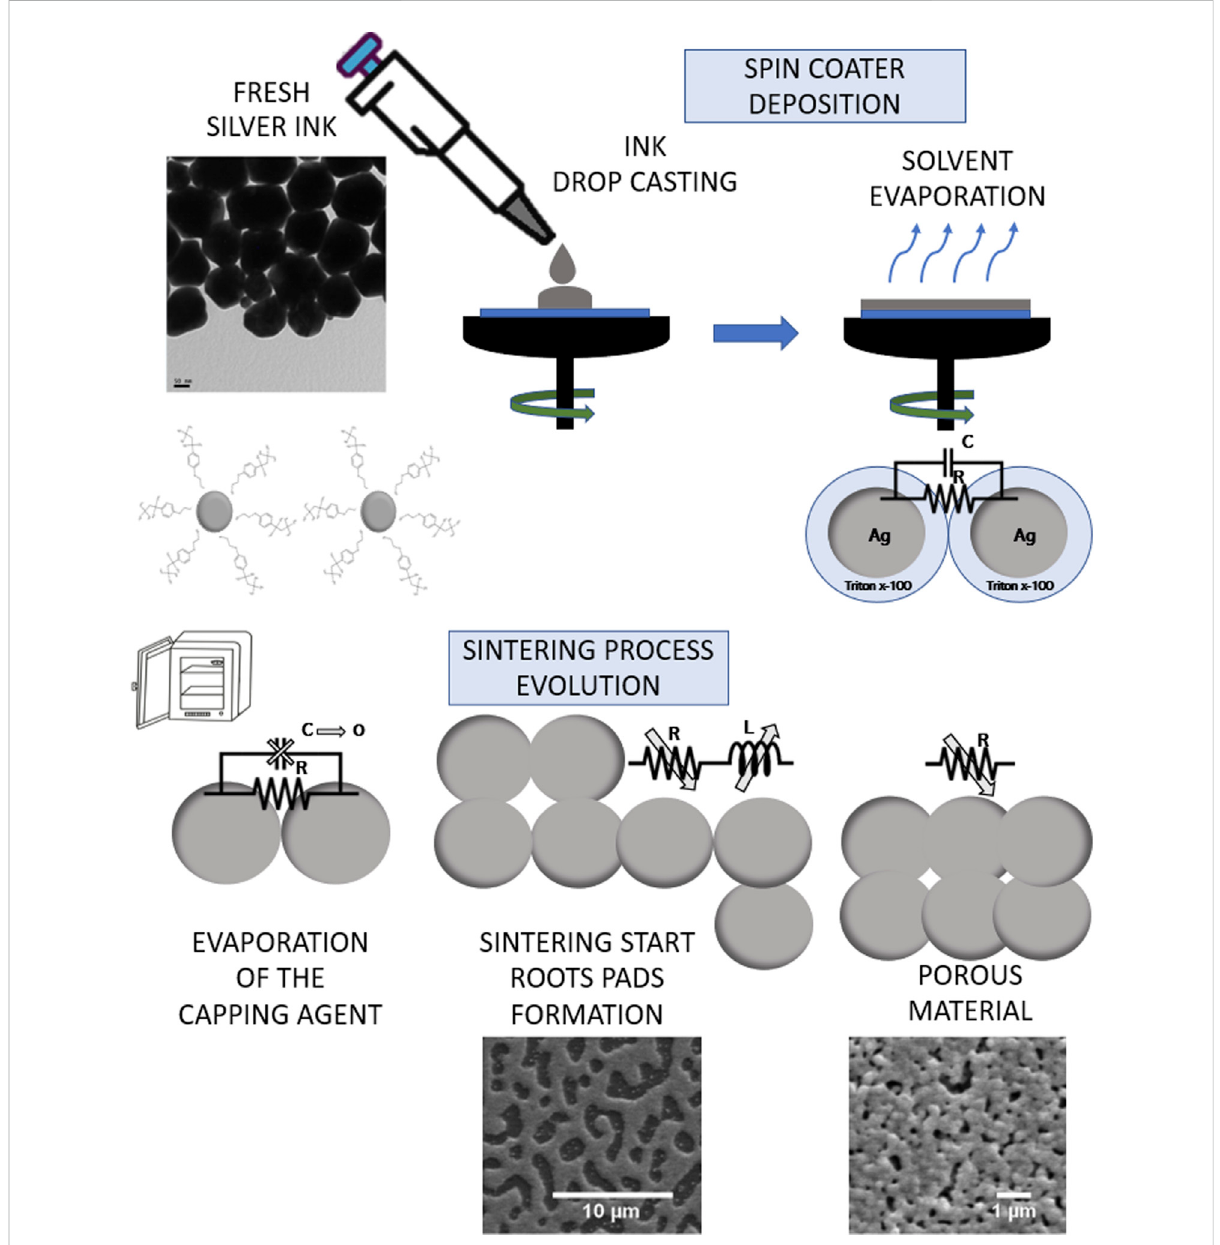
FIGURE 1 Schematic of the drying process, fi rst the sample is placed in a spin coater, the solvent is evaporated at room temperature, and the Ag NPs are isolated fromeachotherdueto thecappingagent(capacitive behavior). Whenheatisadded,thesintering processbeginswiththeelimination ofthe capping agent and the interconnection of the Ag